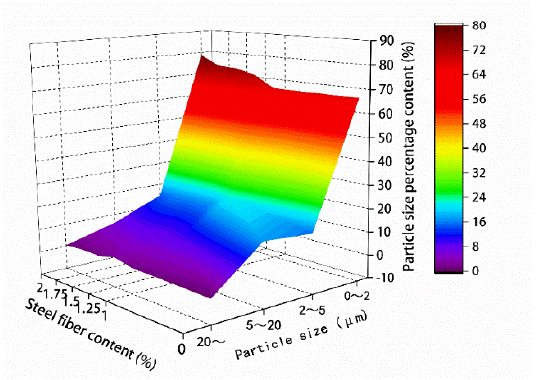
Figure 18. Particle size percentage content.